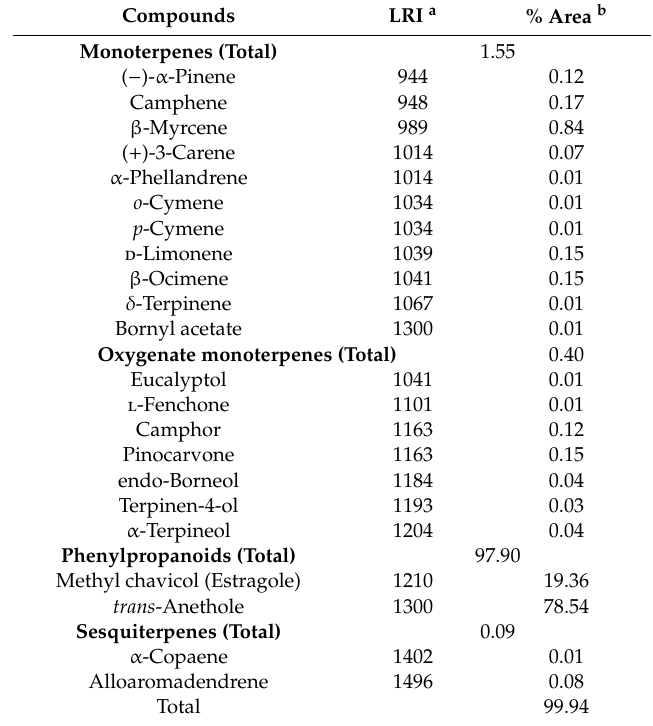
Table 1. Volatile compounds of EOEP analyzed by HS-SPME-GC /